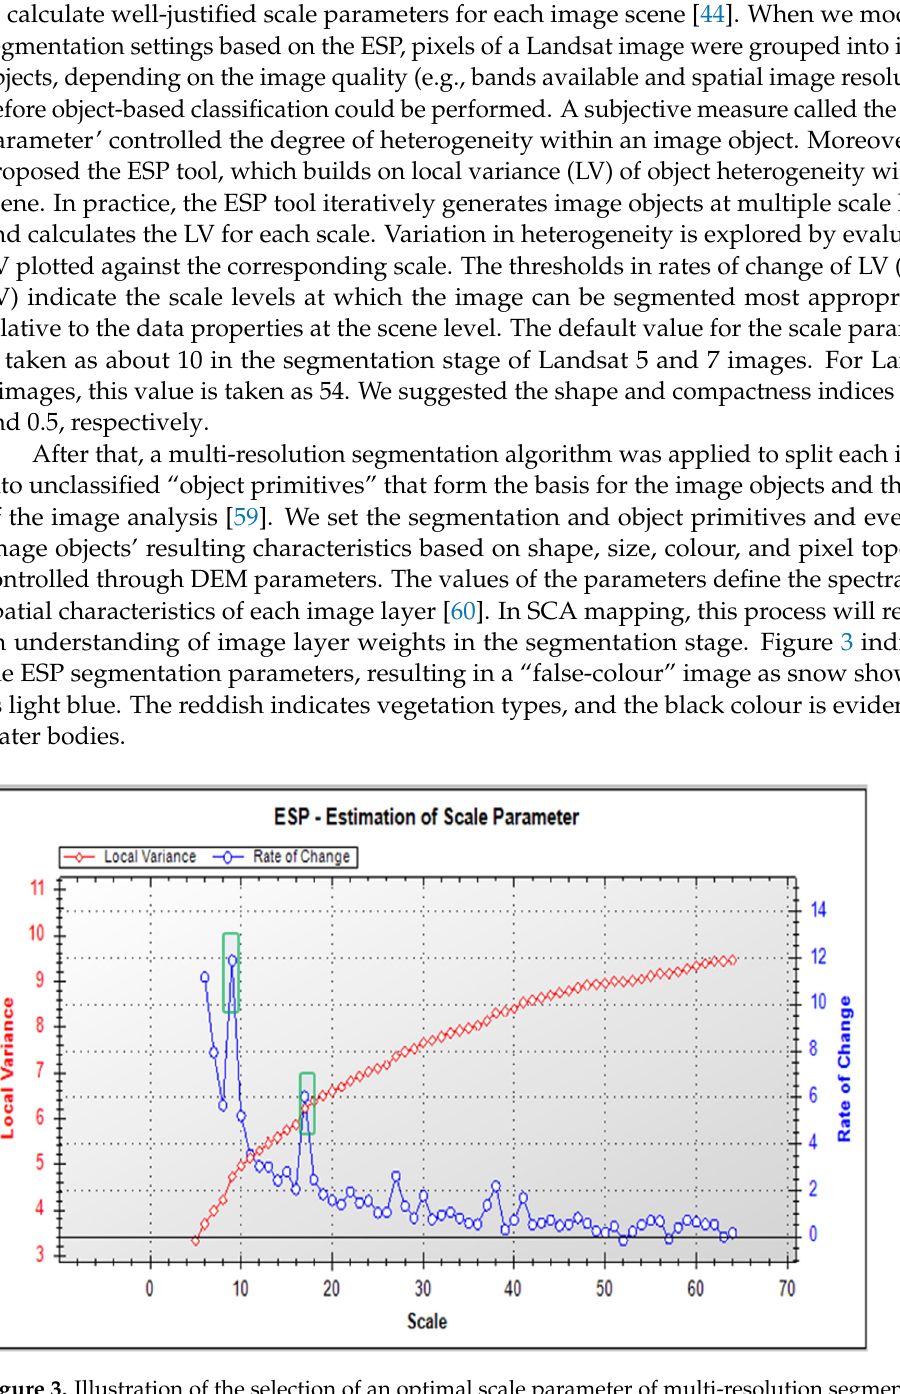
Table 1. A set of equations applied when implementing dynamic rule ‐ based procedures. Index